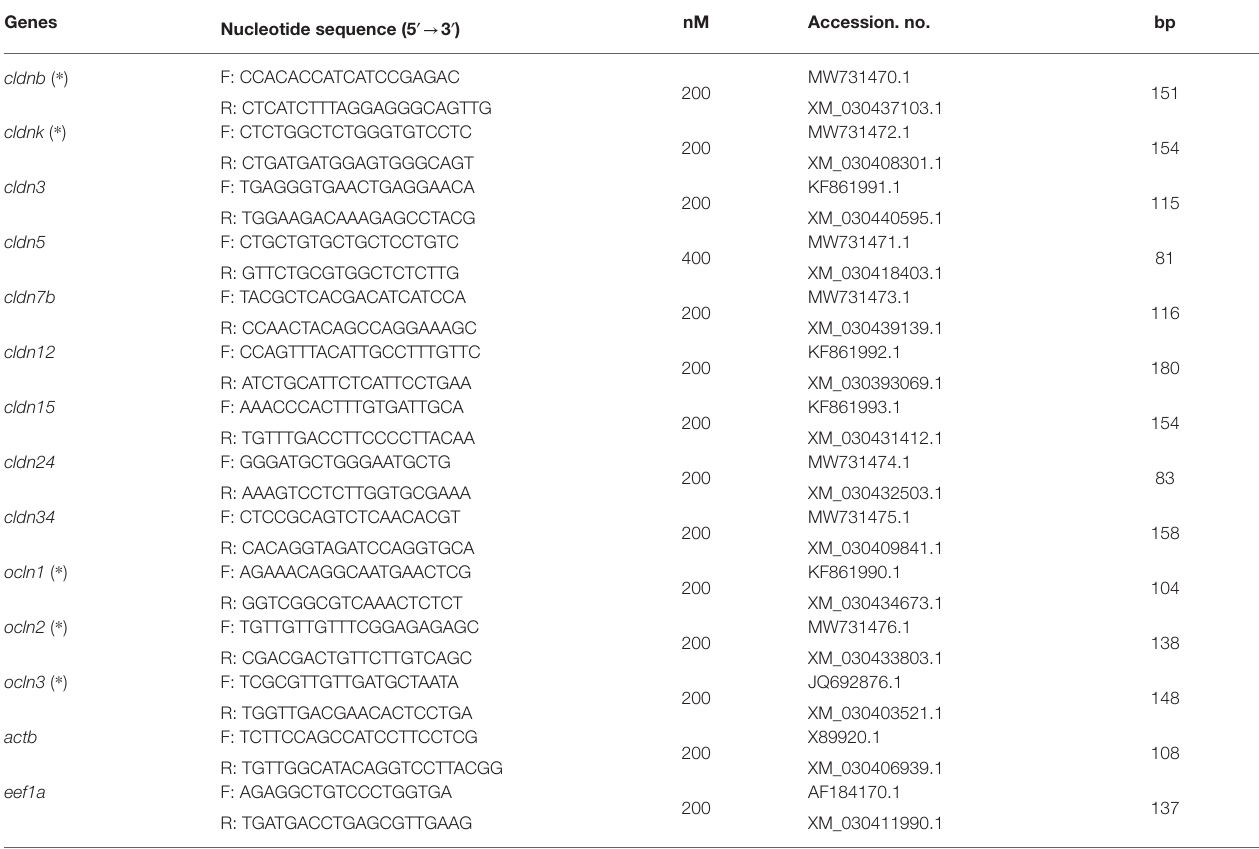
Genes Nucleotide sequence (5